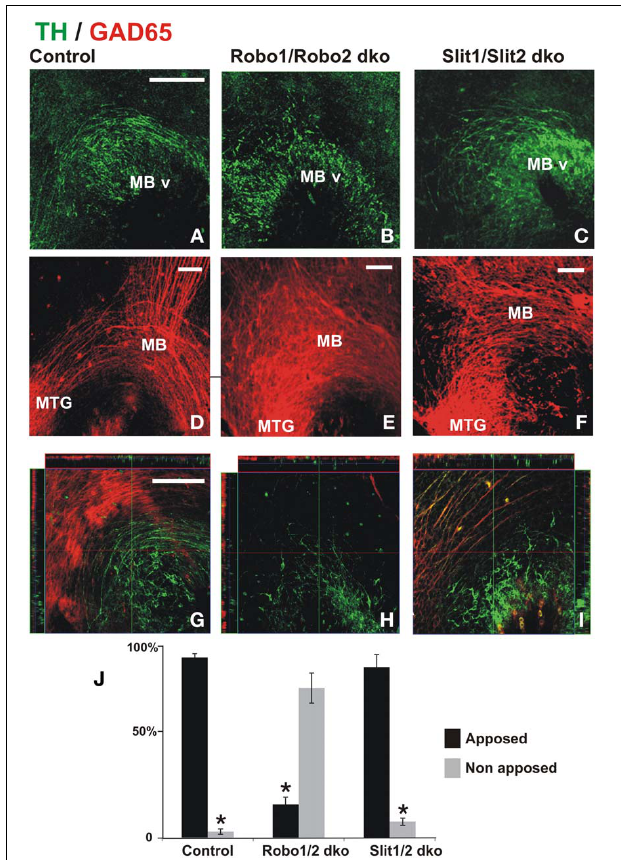
FIGURE 6 | Dopaminergic misprojection in mouse embryos lacking either Robo1/Robo2 or Slit1/Slit2 is accompanied by dramatic alterations in the GAD65 axon bundles. Brains from control (A,D,G) , Robo1/Robo2 double knock out (dko) (B,E,H) , or Slit1/Slit2 dko (C,F,I) E12 mouse embryos were double immunostained for TH (green) and GAD65 (red) and hemibrains were mounted flat for observation. Normal projection at this early stage of TH + axon pathfinding can be observed in (A) (control). Dramatic reduction and misprojection of TH axons is observed in (B) (Robo1/Robo2 dko), and (C) (Slit1/Slit2 dko). (D–F) Show GAD65 immunostaining of the same areas; in (D) , normal GAD65 axon scaffolds are observed while notable alterations in the scaffold are observed in double knockouts (dko) (E,F) being more dramatic in Robo1/Robo2 dko (E) . (G–I) Show single focal planes of the same regions with ortohogonal projections at the red and green lines shown. Apposition of TH axons on the orthogonal projections shown in (G–I) was quantified and is shown in (J) . Significance ( ∗ ) in (J) is p < 0 . 05. Scale bar: 100 μ m.